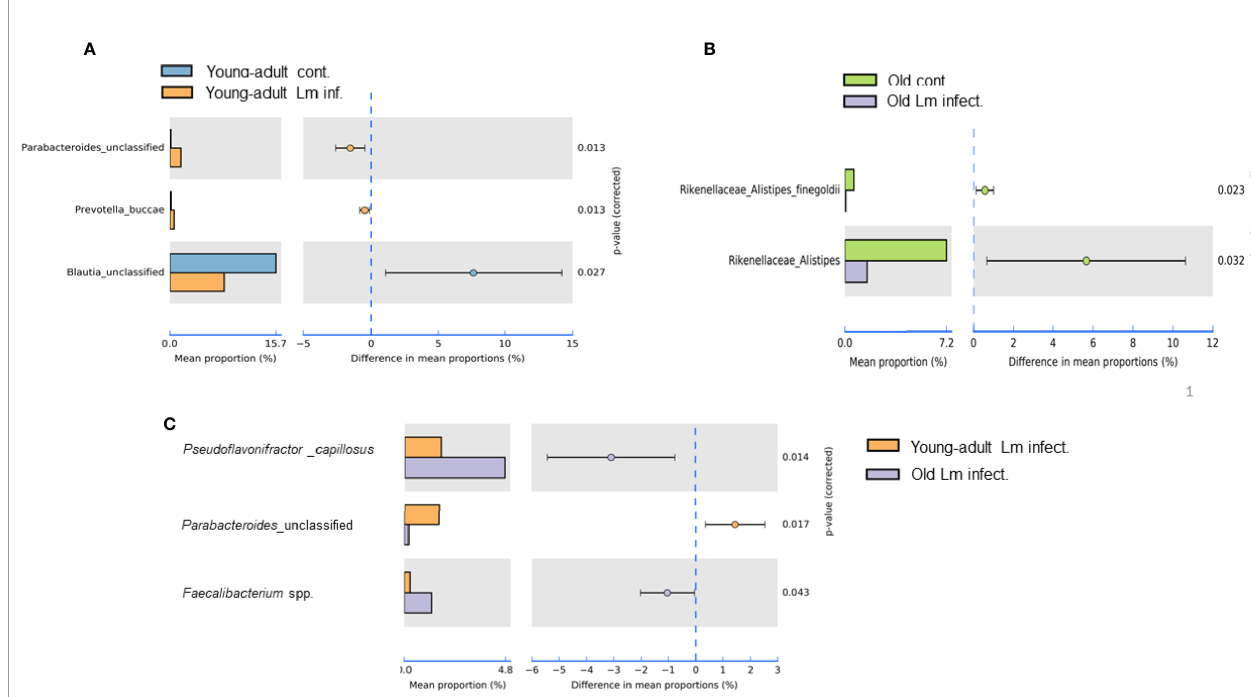
FIGURE 5 | Species level relative abundance of fecal bacteria in young-adult and old mice before and after Listeria monocytogenes infection. (A) Listeria -infection induced changes of bacteria Parabacteroides , Prevotella buccae , Blauia in young-adult mice before and after Listeria monocytogenes infection. (B) Listeria -infection induced changes of bacterial species of the Rikenellaceae family that included the genus Alistipes , in particular Alistipes fi negoldii , in old mice before and after Listeria monocytogenes infection. (C) L. monocytogenes infection induced changes in abundance Pseudo fl avonifractor capillosus , Parabacteroides , and Faecalibacterium spp. in young-adult and old mice. Relative abundance levels were calculated at the 95% con fi dence intervals and p -value calculated for signi fi cance as shown in the fi gure. The relative abundance of Taxa at the genus level were generated from a k-mer database used for taxonomic pro fi ling. Data from mean ± SEM from a representative experiment using 4 – 6 mice.